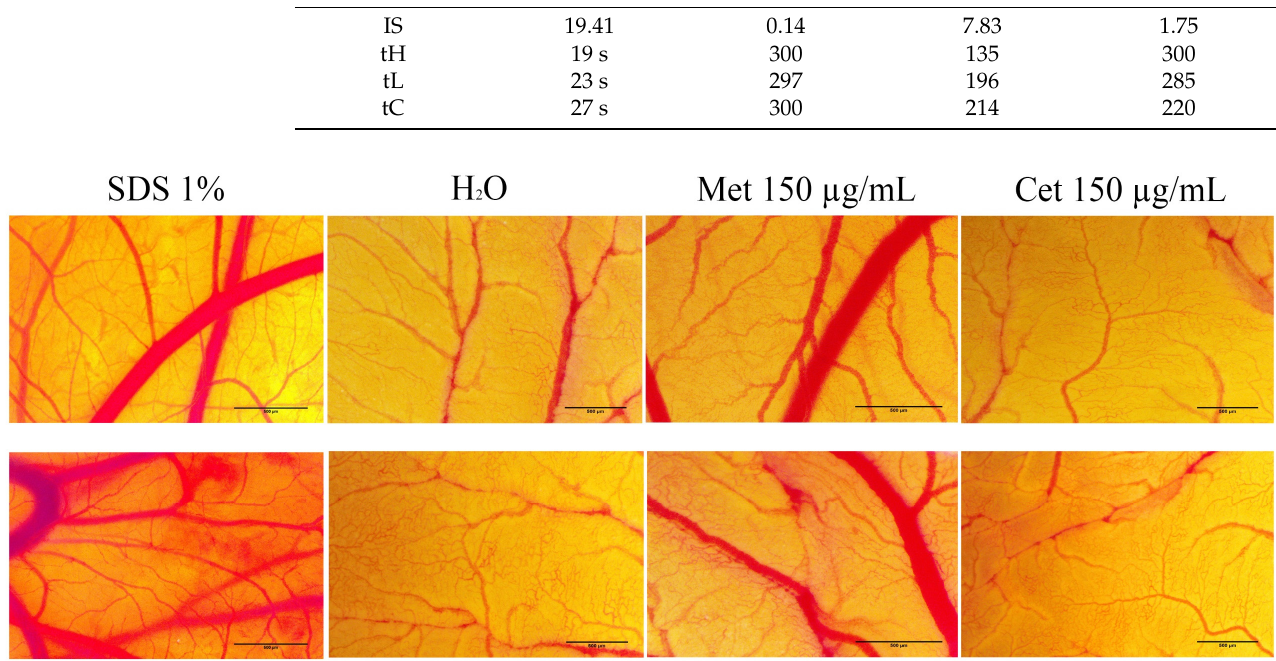
Figure 6. Stereomicroscope images of the CAMs treated with controls (H 2 O used as negative control and sodium dodecyl sulfate—SDS used as positive control) and test samples (Methotrexate and Cetuximab) before inoculation (T0) and five minutes (T5) post-treatment. Scale bars represent 500 µm.